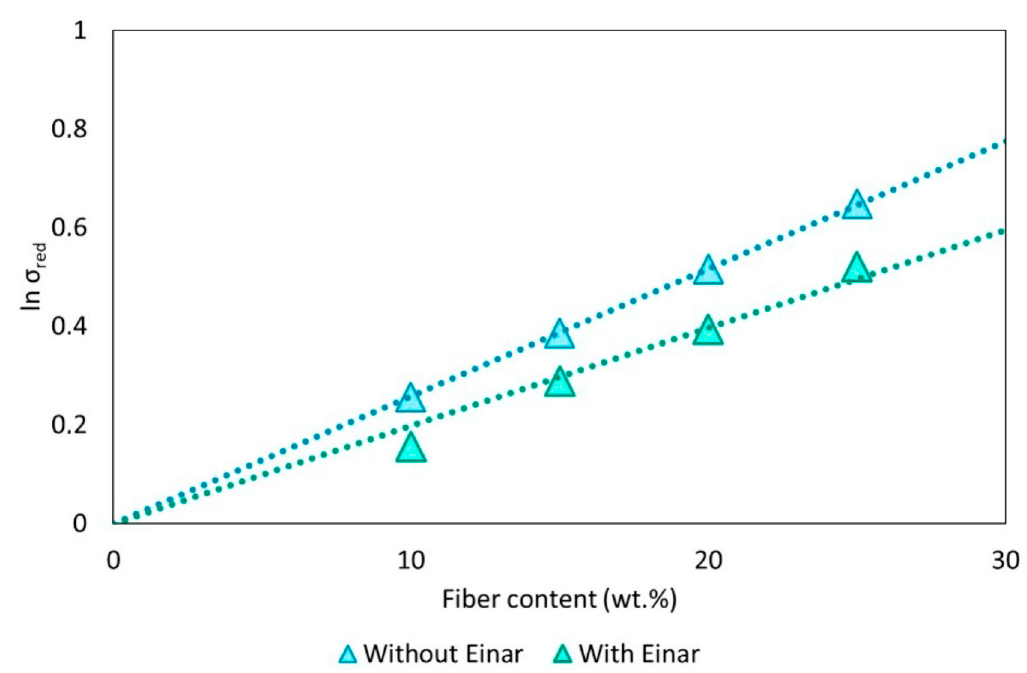
Figure 6. Puk á nszky’s plot for PLA-Arbcocel composites with and without Einar. Figure 6. Pukánszky’s plot for PLA-Arbcocel composites with and without Einar. Table 5. IFSS evaluation for PLA / Arbocel composites with and without